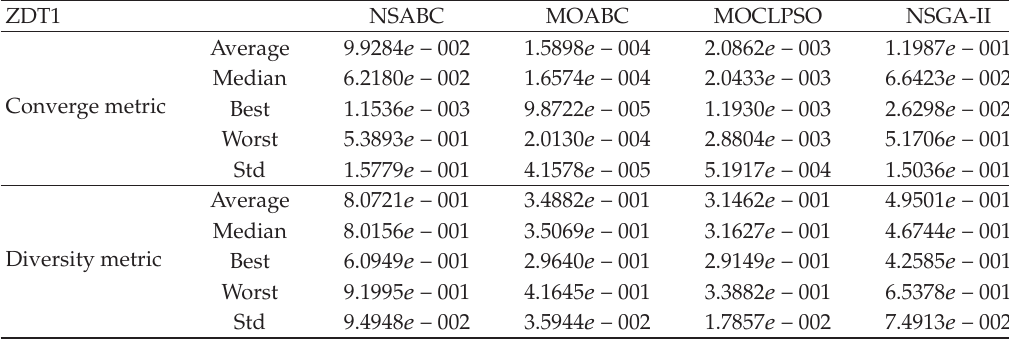
Figure 13: The true Pareto optimal front on DTLZ1. Table 6: Comparison of performance on ZDT1 after 20000